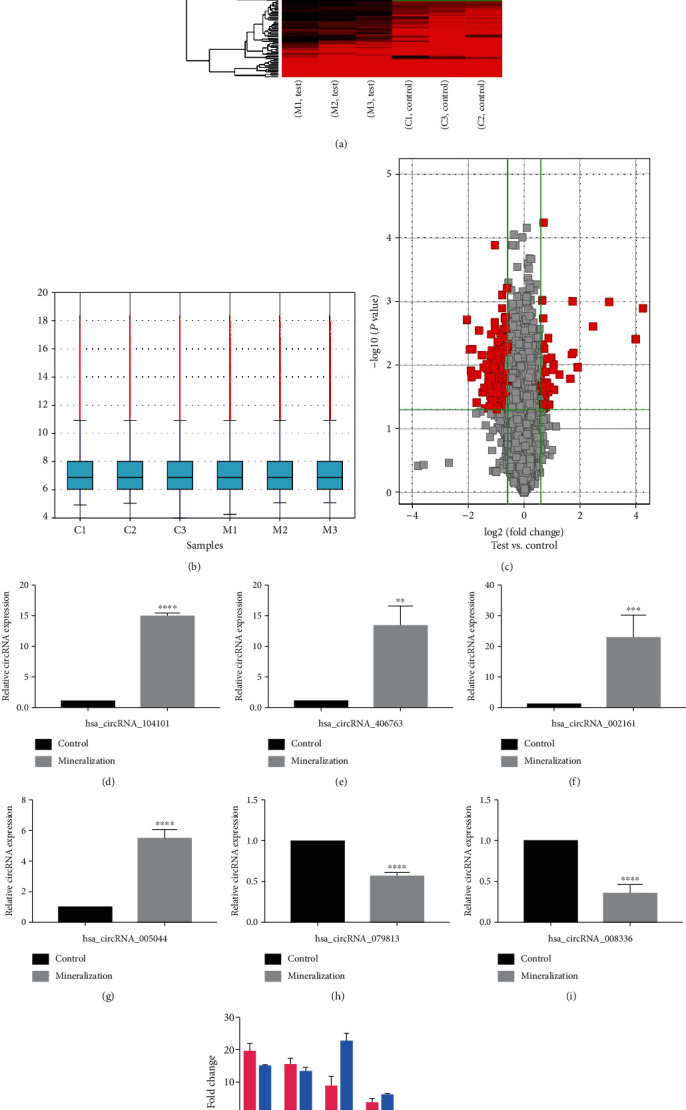
Differentially expressed circRNAs between different groups, differentially expressed circRNAs validated by qRT-PCR. (a) Hierarchical cluster analysis of circRNAs in the induced and noninduced groups by gene chip. The parts of red and green, respectively, mean the upregulation and downregulation of circRNA. (b) Box plot indicated that the distribution of the intensities among all samples was nearly the same. (c) Red font in the volcano plot denotes the differentially expressed circRNAs with statistical significance from hDPSCs between the induced and noninduced groups (fold change > 1.5 or <-1.5, P < 0.05). (d–g) circRNA hsa_circRNA_104101, hsa_circRNA_406763, hsa_circRNA_002161, and hsa_circRNA_005044 were upregulated in the induced group in comparison with the noninduced group. (h, i) circRNAs hsa_circRNA_079813 and hsa_circRNA_008336 were downregulated. The data were represented as means ± SD. ∗P < 0.05, ∗∗P < 0.01, ∗∗∗P < 0.001, and ∗∗∗∗P < 0.0001. (j) Results of the comparison of microarray and qRT-PCR data for candidate circRNAs.